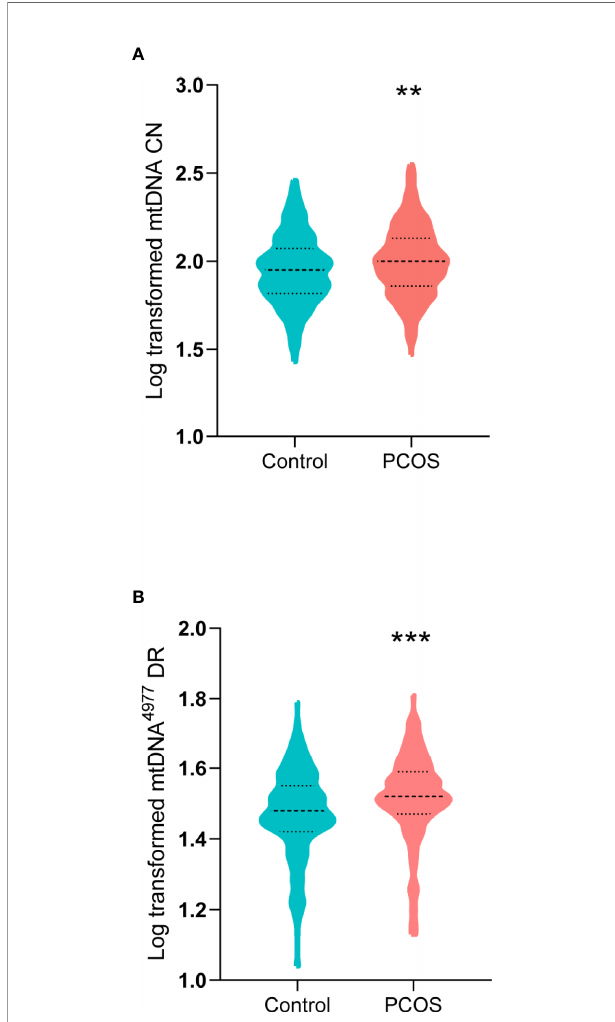
FIGURE 1 | MitochondrialDNA(mtDNA)copynumber(CN)andmtDNA4977 bp(mtDNA 4977 )deletionrate(DR)inwomenwithPCOSandcontrols. (A)